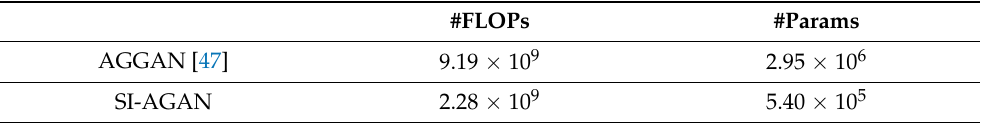
Table 17. Comparison of FLOPs and parameters between AGGAN and SI-AGAN. #FLOPs and #Params refer to the total number of FLOPs and trainable parameters, respectively.